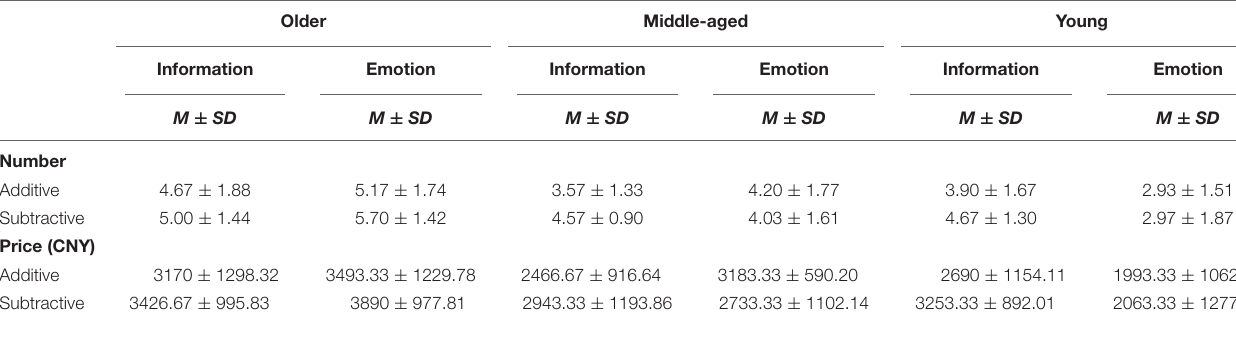
TABLE 5 | Number and total price of accepted options in different focus conditions and option